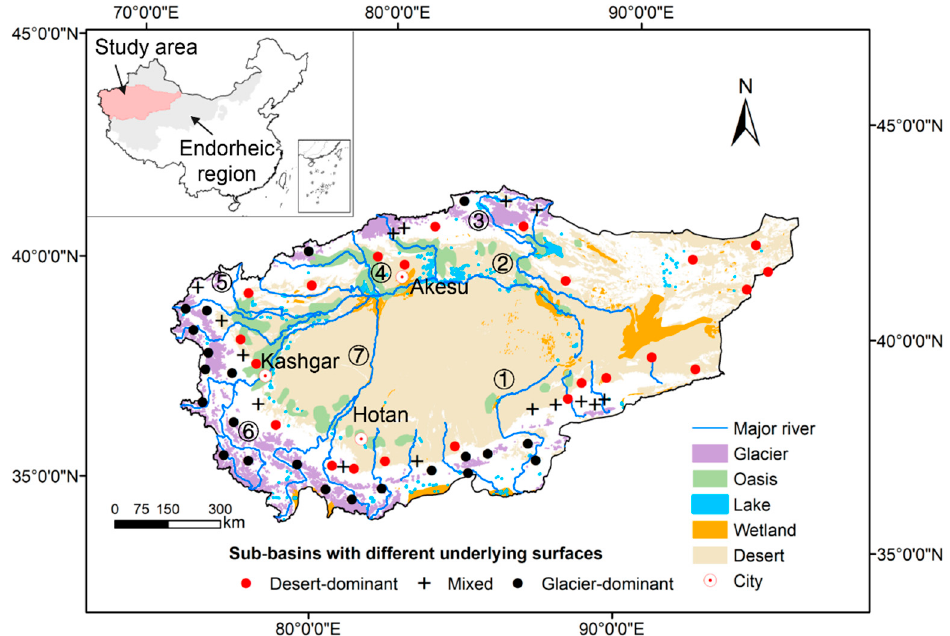
Figure 1. Study area. Location of representative sub-basins with different underlying surface conditions in the Tarim River basin. ① – ⑦ refer to major rivers in the study area, correspondingly named Qarqan River, Tarim River, Kaidu River, Aksu River, Kashgar River, Yarkant River, and Hotan River.